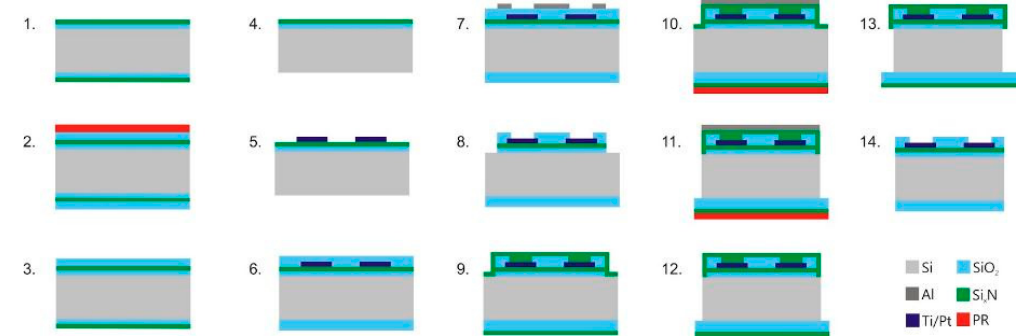
Figure 2. Fabrication sequence of INS electrodes. ( 1 ) SiO 2 and Si x N y deposition; ( 2 ) LTO deposition and front-side photoresist protection; ( 3 ) HF etch and PR removal; ( 4 ) Backside nitride and oxide removal; ( 5 ) Ti/Pt deposition and lift-off; ( 6 ) LTO deposition; ( 7 ) Deposition, photolithography and etching of Al mask for DRIE; ( 8 ) Dielectric stack removal in DRIE and Al removal in wet etchant; ( 9 ) Si x N y deposition; ( 10 ) Deposition, photolithography and etching of Al mask for DRIE with backside PR protective layer; ( 11 ) Deep silicon etching in DRIE; ( 12 ) Removal of Al mask and protective PR layer; ( 13 ) Wet chemical polishing; ( 14 ) HF etch and Si x N y removal in phosphoric